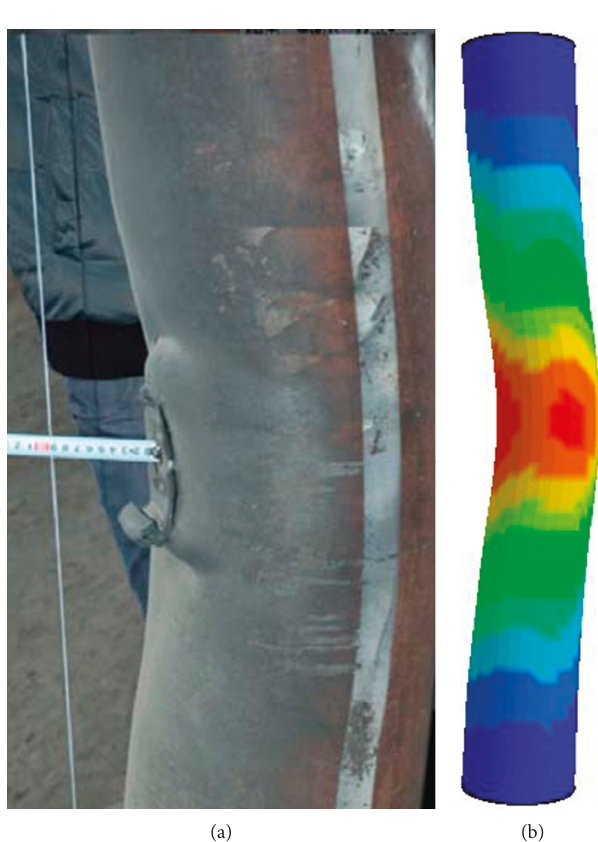
Figure 6: Damage mode of SC-2. (a) Experimental results. (b) Numerical